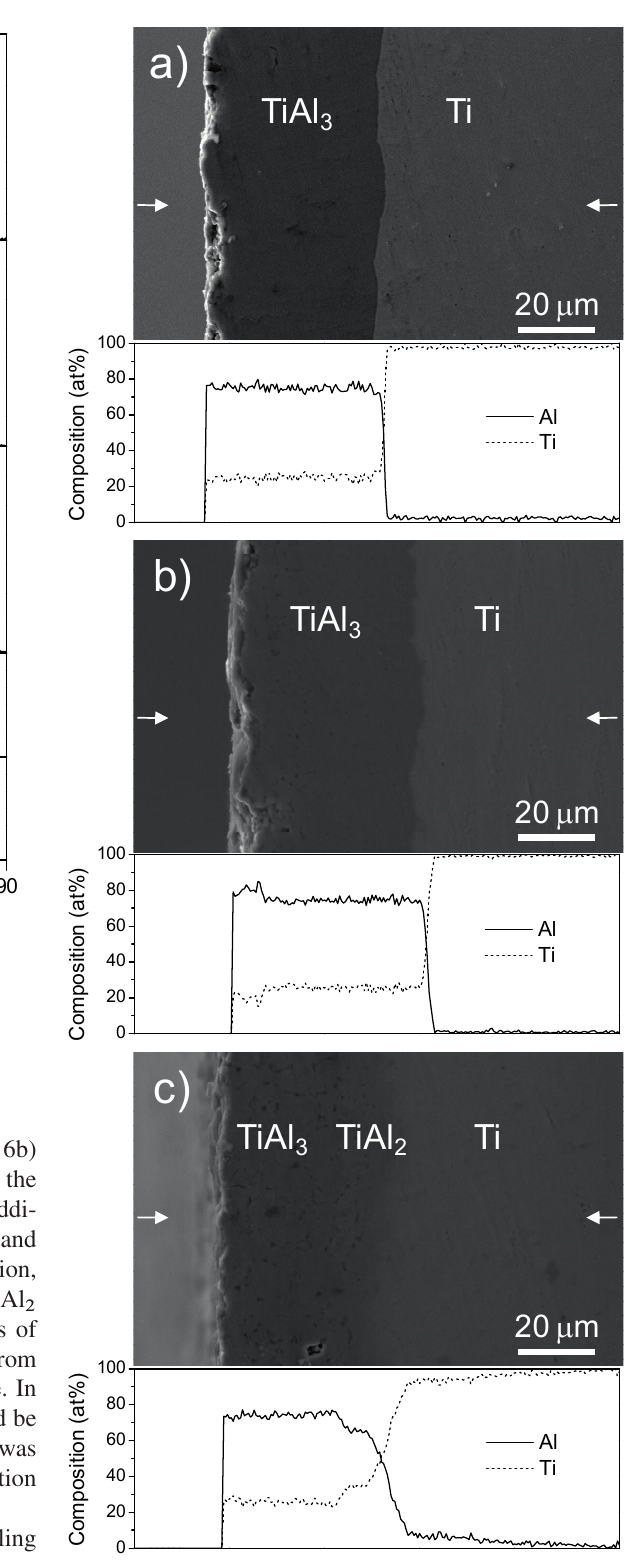
Fig. 6: Figure 6. Cross-sectional SEM images and EDX line anal- ysis of the samples annealed at a) 650 °C, b) 700 °C and c) 1000